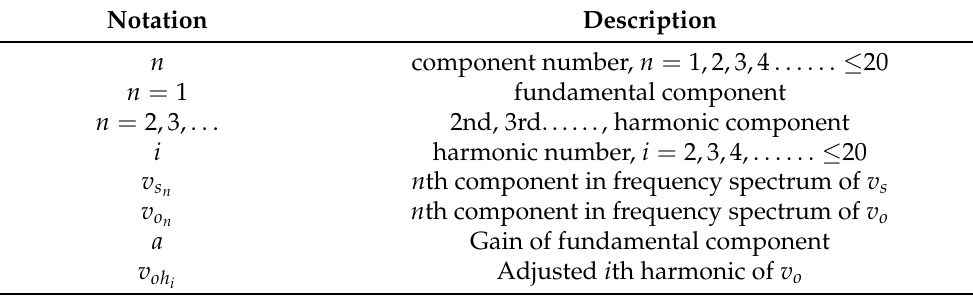
Table 6. Description of the notations in THD algorithm.